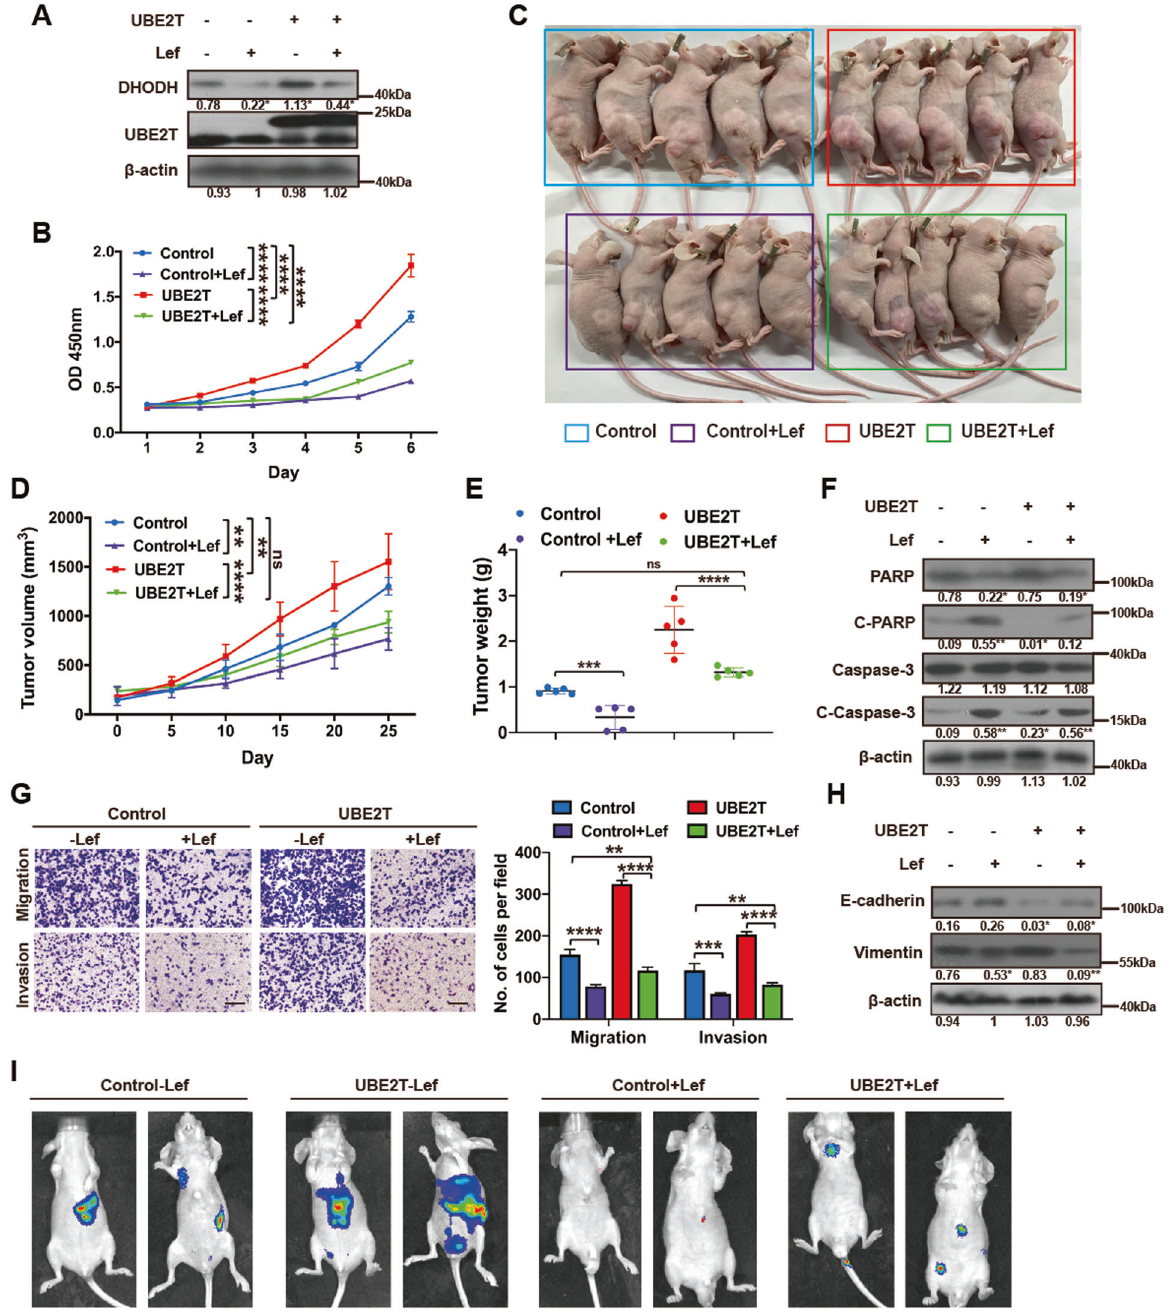
Fig. 4 Le fl unomide impairs UBE2T-induced proliferation and metastasis in HCC. A Total cells lysate from UBE2T-overexpressing and control HCC-LM3 cells treated with or without Lef (50 μ M, 48 h) were analyzed by WB. B Cells were treated as panel ( A ). Cell survival was assessed by CCK-8 assay. Experiments were repeated at least three times. C Transplanted xenografts were established with UBE2T-overexpressing (UBE2T) and vector transduced (Control) HCC-LM3 cells. The tumor-bearing mice were treated with or without Lef (7.5 mg/kg/d) by intraperitoneal injection. D Tumor volumes from each group were tracked for 25 days. N = 5 in each group. E Tumor weights of the removed xenografts from each group were measured. F Total cells lysate from the cells treated as panel ( A ) were analyzed for the apoptosis markers by WB. G Transwell assay to assess the migration and invasion ability of the cells treated as panel ( A ). Quanti fi cation of cell numbers per fi elds is from at least three independent experiments. Scale bar = 100 μ m. H Total cells lysate from the cells treated as panel ( A ) were analyzed for the EMT markers by WB. I UBE2T-overexpressing and control HCC-LM3 cells were injected in nude mice by tail vein. The tumor-bearing mice were treated with or without Lef (7.5 mg/kg/d) by intraperitoneal injection. Bioluminescence images were collected at 30 days. The luminescence signal is represented by an overlaid false-color image with the signal intensity indicated by the scale. All values shown are mean ± SD. * P < 0.05, ** P < 0.01, *** P < 0.001, **** P < 0.0001. In B , E , and G , one-way ANOVA was used for comparison between treatment groups, and Tukey post hoc test was used for two-group comparisons. In D , two-way ANOVA was used for comparison between groups. The average gray values and the statistical data were shown under the corresponding band. Student ’ s t- test was used for comparisons, * P < 0.05, ** P < 0.01.